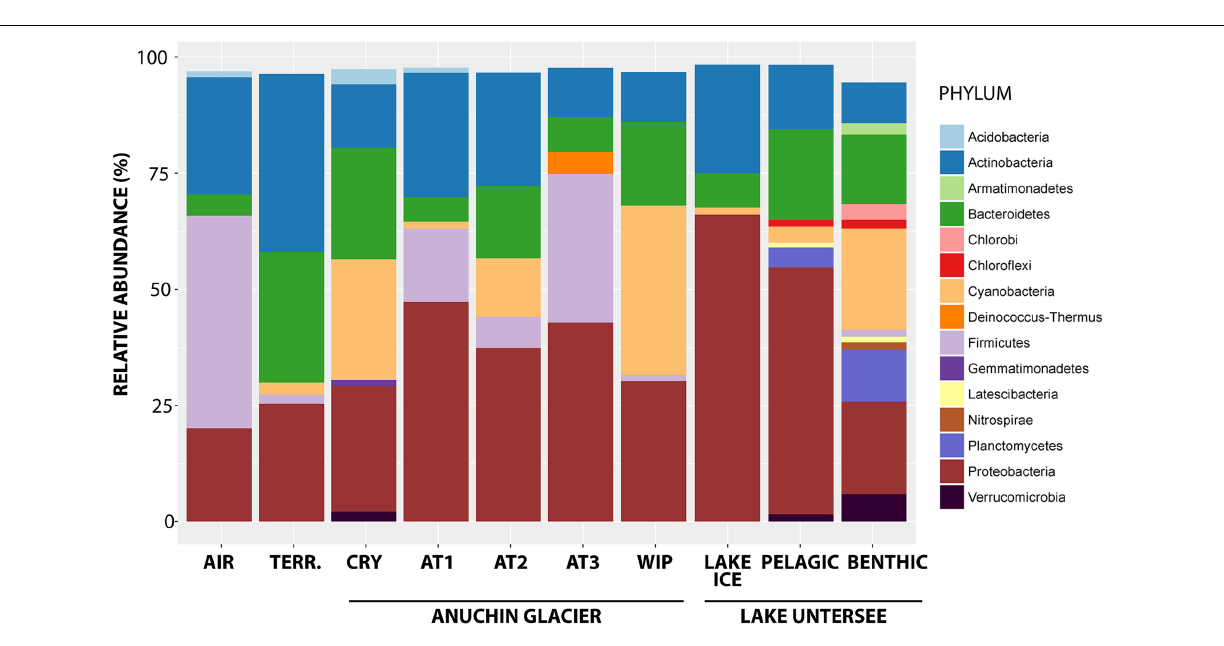
FIGURE 4 | Bacterial phyla from the Anuchin Glacier, Lake Untersee and its surroundings. TERR, terrestrial samples; CRY, cryoconite holes; AT1-3, parallel ice transects along Anuchin Glacier; WIP, white ice patch in Lake Untersee. Sequences unidentified at the genus level and low abundant phyla (abundance < 1%) were